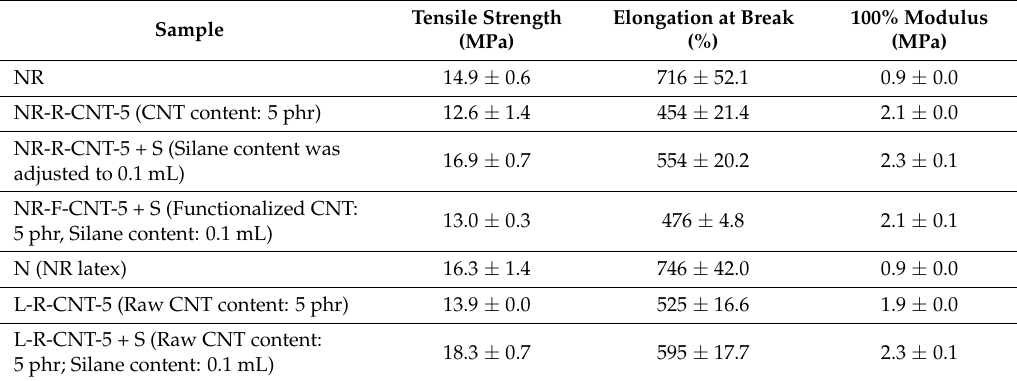
Table 5. Mechanical properties of NR gums and carbon nanotubes (CNT) composites of melt and latex–based samples (Modified). Reproduced with permission from Wiley